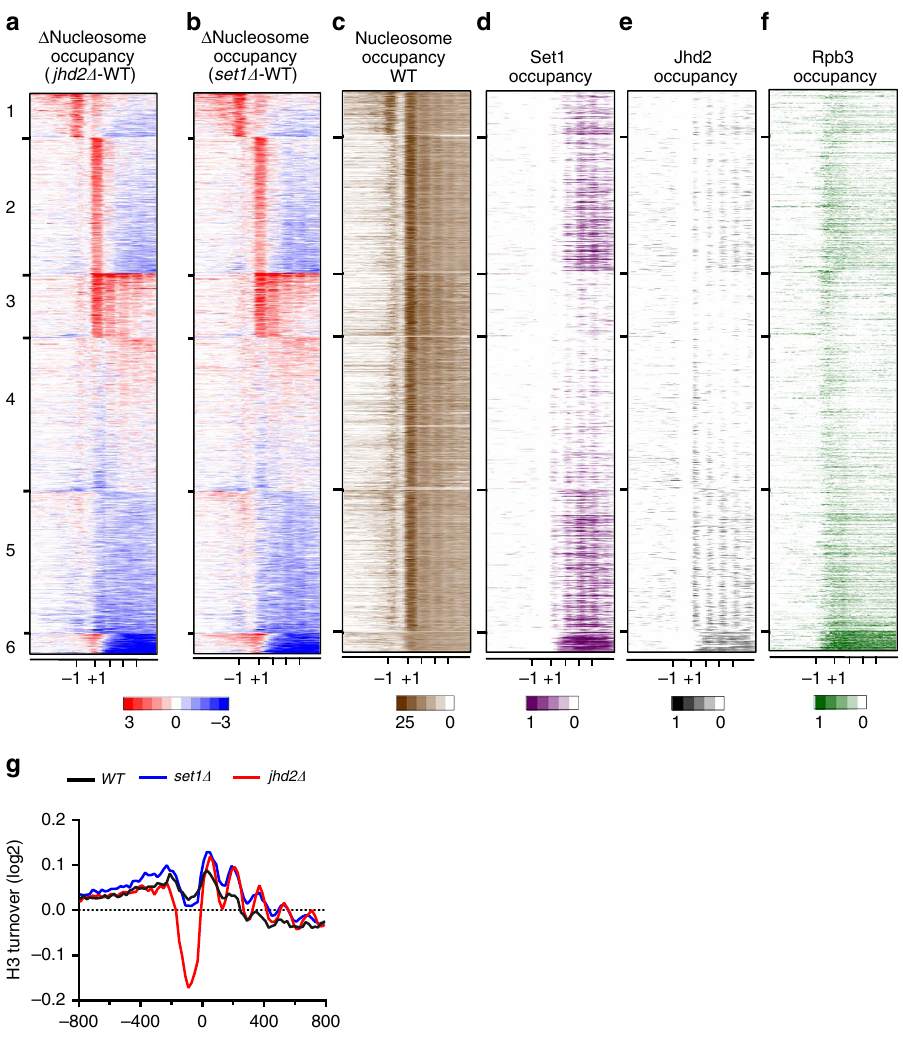
Figure 6 | Set1 and Jhd2 co-regulate chromatin structure and nucleosomal turnover genome-wide during transcriptional regulation in yeast. ( a ) Nucleosome occupancy ratios ( D nucleosome occupancy) between jhd2 D and control WTacross all yeast genes are shown as a heat map, where gain or loss in nucleosome occupancy are in red and blue, respectively. Genes in rows are organized into six k-means clusters. Columns represent 50bp windows over ± 800bp regions relative to the TSS. Relative positions for (cid:2) 1, þ 1 and other coding regions nucleosome are indicated at the bottom. Windows overlapping neighbouring genes were excluded. ( b ) Heat map for D nucleosome occupancy between set1 D and WT across all yeast genes. Heat map details are as described for a . ( c ) Native nucleosome occupancy for genes in the six k -means clusters generated from reads obtained in WT are shown. Nucleosome occupancy above global mean is in brown. ( d , e ) Heat maps for Set1 and Jhd2 occupancy within the six clusters are shown. ( f ) Heat map for Rpb3 occupancy within the six k -means clusters, using published data 51 , is shown. Pol2 subunit occupancy above global mean is in green (Supplementary Fig. 14b). ( g ) The average mean profile for histone H3 turnover across 800bp region upstream ( (cid:2) ) or downstream ( þ ) of the TSSs (0) at all yeast genes in WT , set1 D and jhd2 D are